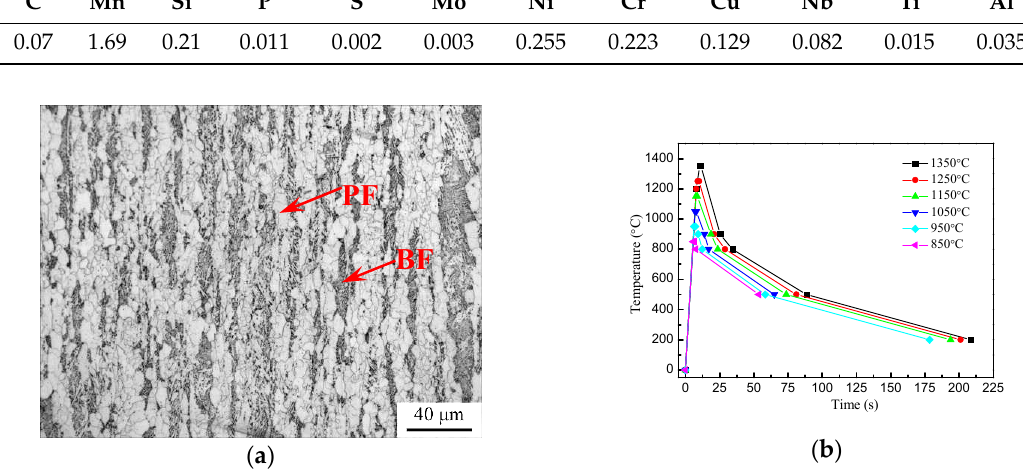
Figure 1. ( a ) Optical micrographs of base metal; ( b ) Thermal cycle procedure for the experiments.